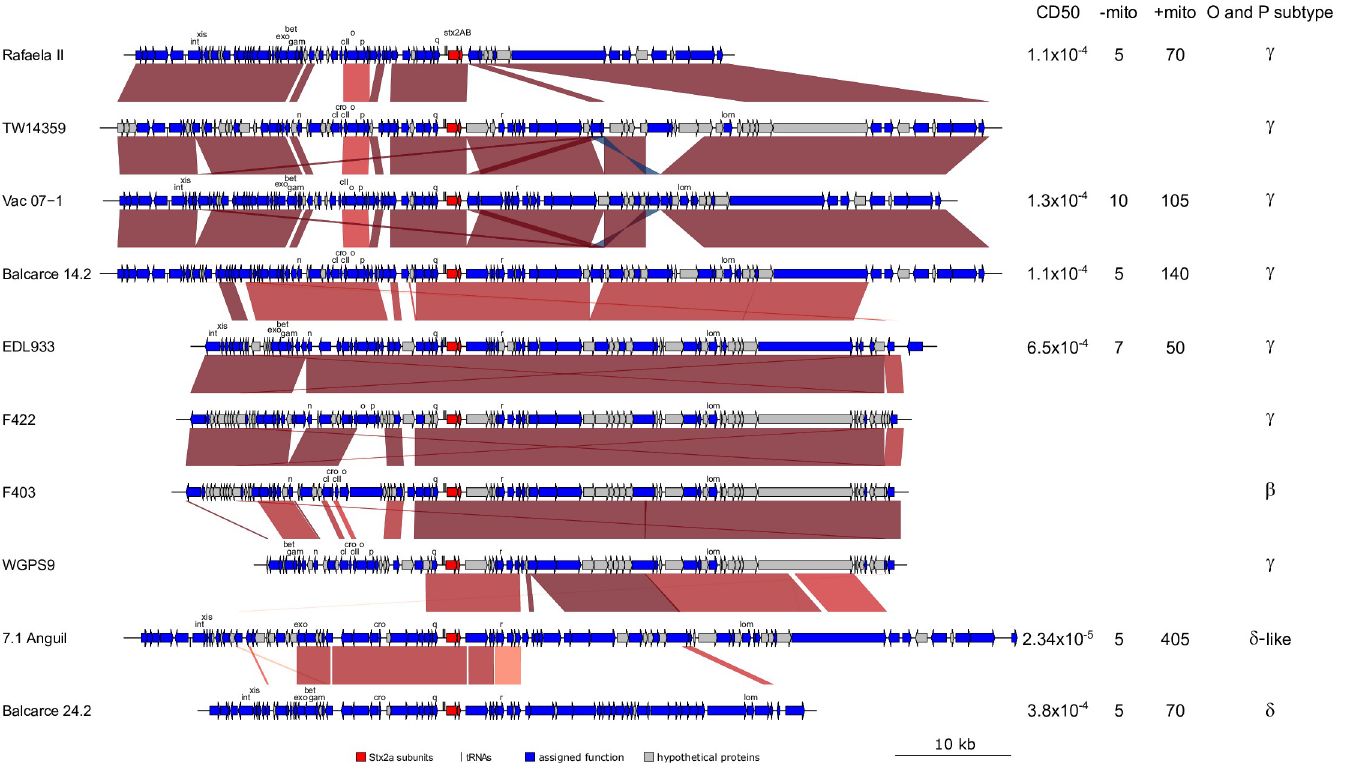
Fig 5. Alignment of prophages carrying stx2 a , the red arrows represent genes of the stx2 a operon; the grey arrows indicate hypothetical proteins, and the blue arrows refer to genes encoding for protein with assigned function. Some relevant genes of lambda phage are marked. Artemis comparison tool was used to indicate regions of similarity (red), inversions (blue) and In/dels (clear) or no homology (no lines). Columns at the right show cytotoxicity in Vero cells, by ELISA with or without mitomicin and O and P protein subtype.